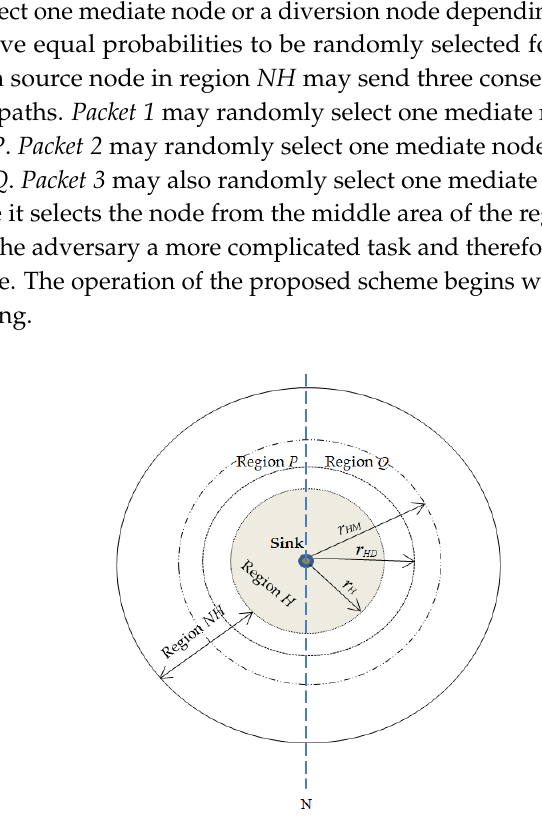
Figure 3. Distribution of regions in the sensor domain.